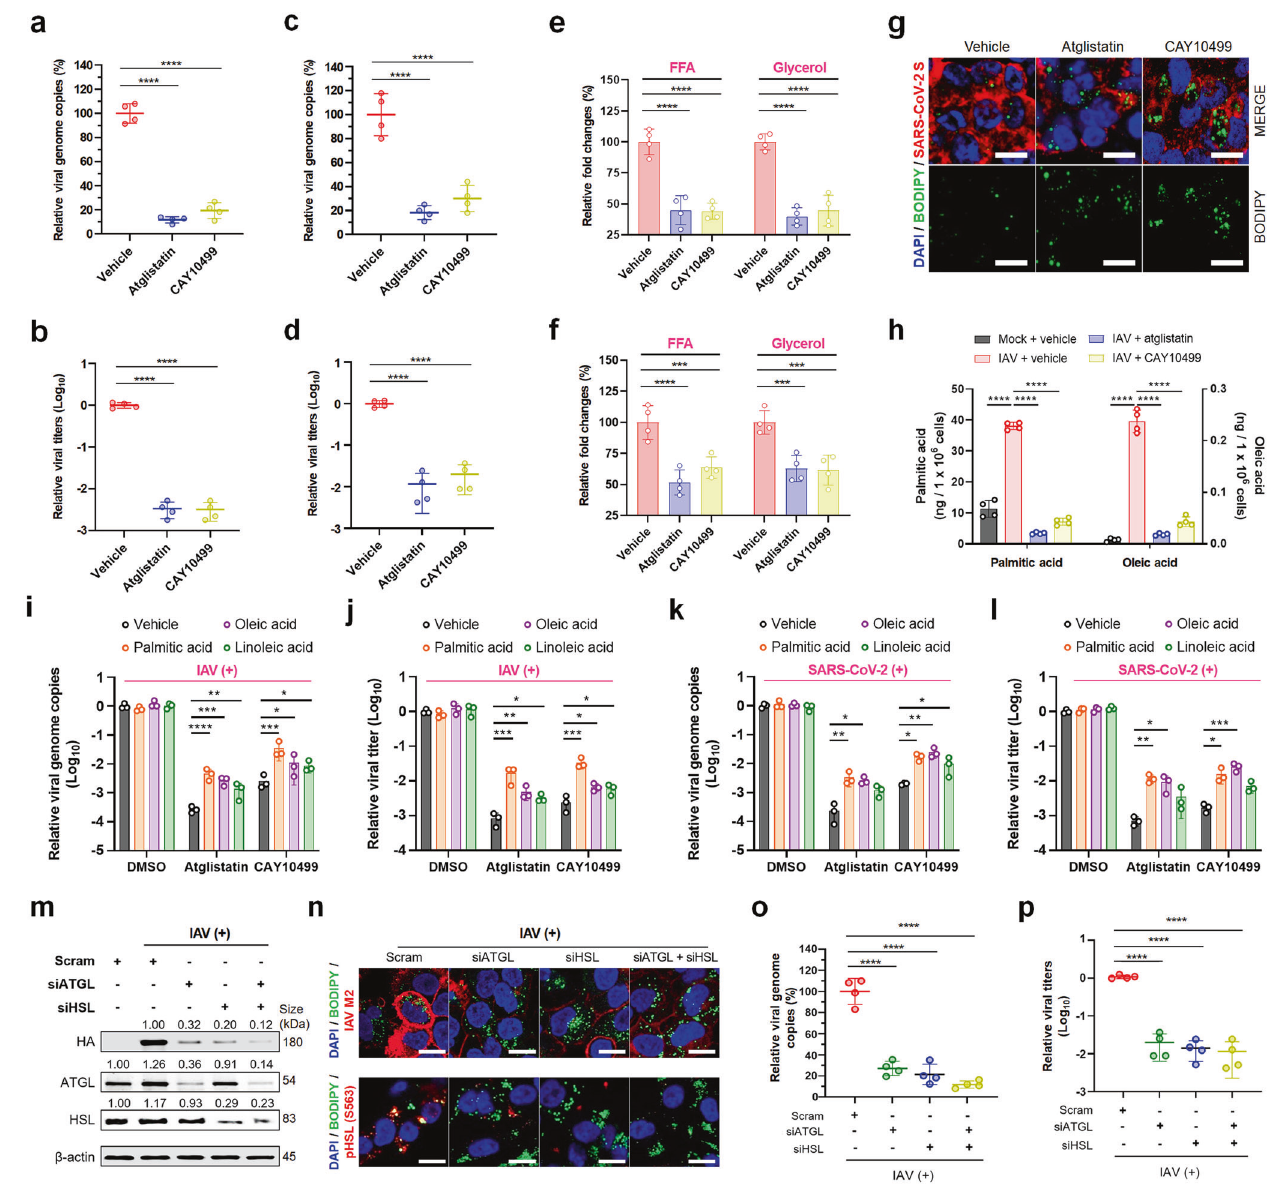
Fig. 2 In vitro reduction in viral replication and proin fl ammatory cytokines through lipolysis inhibition. a , b Reduction in SARS-CoV-2 genome copy number and infectious progeny production by treatment of SARS-CoV-2-infected Vero E6 cells (MOI = 0.1 FFU) with atglistatin or CAY10499 at 20 µM. c , d Reduction in IAV genome copy number and infectious progeny production by treatment of IAV-infected A549 cells (MOI = 1 FFU) with 20 µM atglistatin or CAY10499 at 20 µM. e , f Inhibition of FFA and glycerol release from LDs by the treatment with 20 µM atglistatin or CAY10499 in SARS-CoV-2-infected Vero E6 cells at an MOI of 0.1 ( e ) or IAV-infected A549 cells at an MOI of 1 ( f ). g Retention of LDs (green) with corresponding inhibition of SARS-CoV-2 replication (red) by the treatment of virus-infected cells (MOI = 0.1 FFU) with 20 µM atglistatin or CAY10499. h Graphical representation of LC-MS data. Reduction in palmitic and oleic acids by treatment of IAV-infected A549 cells (MOI = 1 FFU) with 20 µM atglistatin or CAY10499 at 20 µM. i – l Increase in viral genome copy numbers and progeny numbers of IAV and SARS-CoV-2 through individual supplementation of exogenous palmitic, oleic, or linoleic acids in the above FFA-deprived condition. m Representative western blot. Reduction in IAV HA protein levels in knockdown conditions of ATGL and/or HSL in A549 cells infected with IAV PR8 strain (MOI = 1 FFU) or mock-infected controls. n (upper panels) Retention of LDs (green) with corresponding inhibition of IAV replication (red) by knockdown of ATGL and/or HSL in IAV-infected A549 cells (MOI = 1 FFU). Lower panels: reduction in pHSL (S563) level by knockdown of ATGL and/or HSL , resulting in the retention of LDs (green). o , p Reduction in IAV genome copy numbers and infectious progeny production in IAV-infected A549 cells (MOI = 1 FFU) by knockdown of ATGL and/or HSL . All data in the graphs are presented as arithmetic means ± SD from four independent experiments. * P < 0.05; ** P < 0.01; *** P < 0.001, **** P < 0.0001, one-way analysis of variance with Tukey ’ s correction for multiple comparisons. Scale bars = 50 µm both lipase inhibitors reduce virus-induced cell death. Inhibition of 18 hpi in SARS-CoV-2-infected cells and from 12 hpi in IAV- LD lipolysis by treatment with both lipase inhibitors signi fi cantly infected cells, but cleaved caspase 3 accumulated from 24 hpi in decreased necroptotic (pMLKL) and apoptotic (TUNEL) marker- SARS-CoV-2-infected cells and from 18 hpi in IAV-infected cells, positive cells (Supplementary Fig. 10a, b) along with the marked respectively (Supplementary Fig. 9c, d). We next checked whether Signal Transduction and Targeted Therapy (2022)